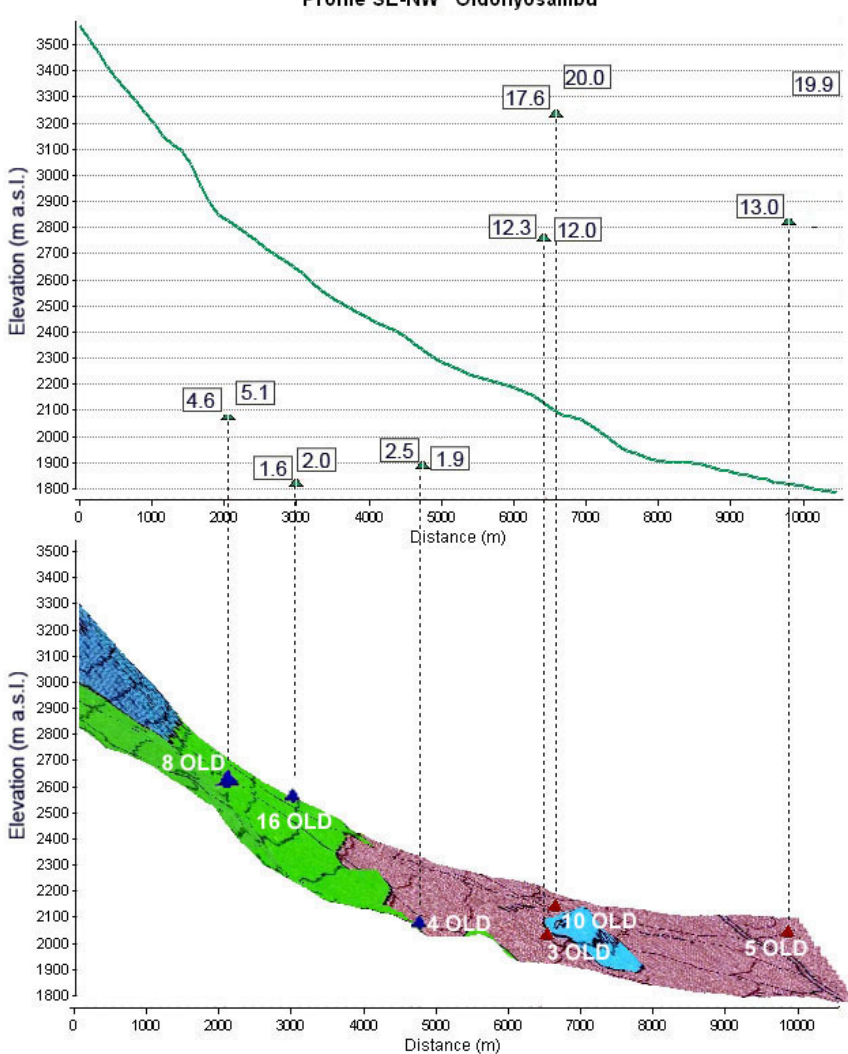
Fig. 10. Cross section of the NW side of Mt. Meru, showing the location of the springs and the fluoride content of the spring waters (mgl − 1 ) for the Masika (left) and pre- Masika (right) survey.